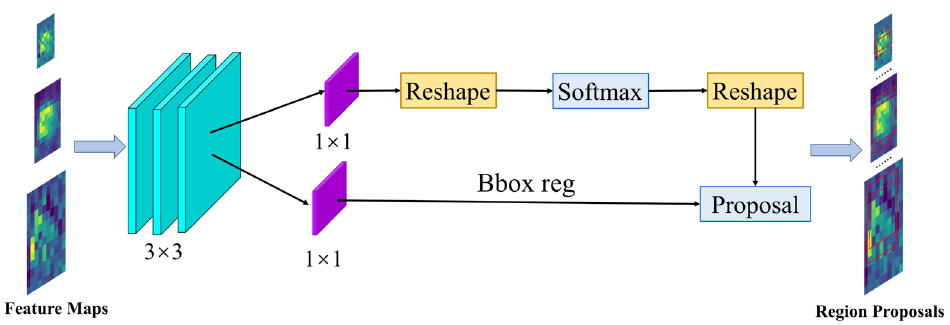
Figure 7. The architecture of the RPN.